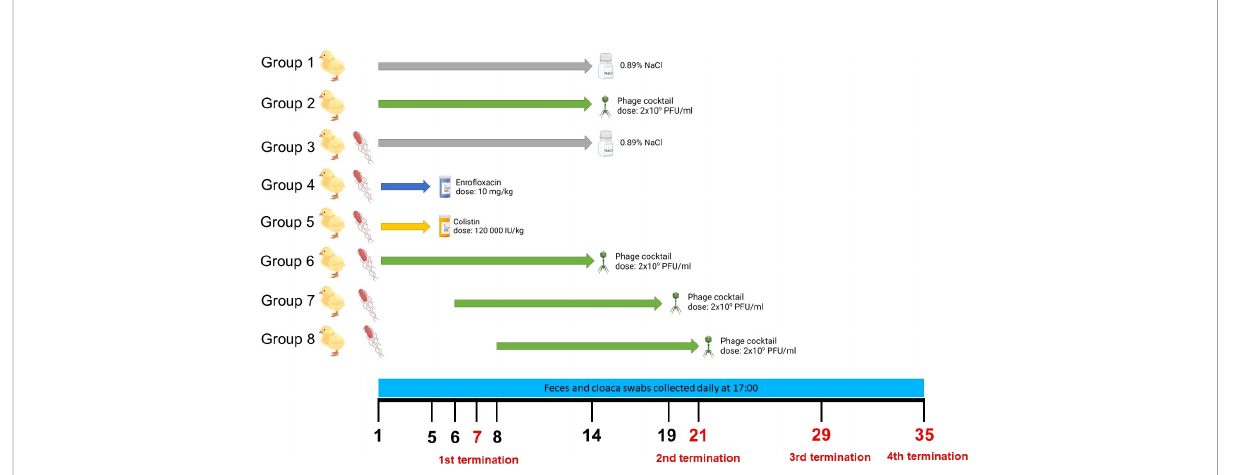
FIGURE 1 Experimental groups of chickens used in the experiments, the scheme of treatment variants of particular groups, and the time scale of sample collections and terminations. The fi gure was created with